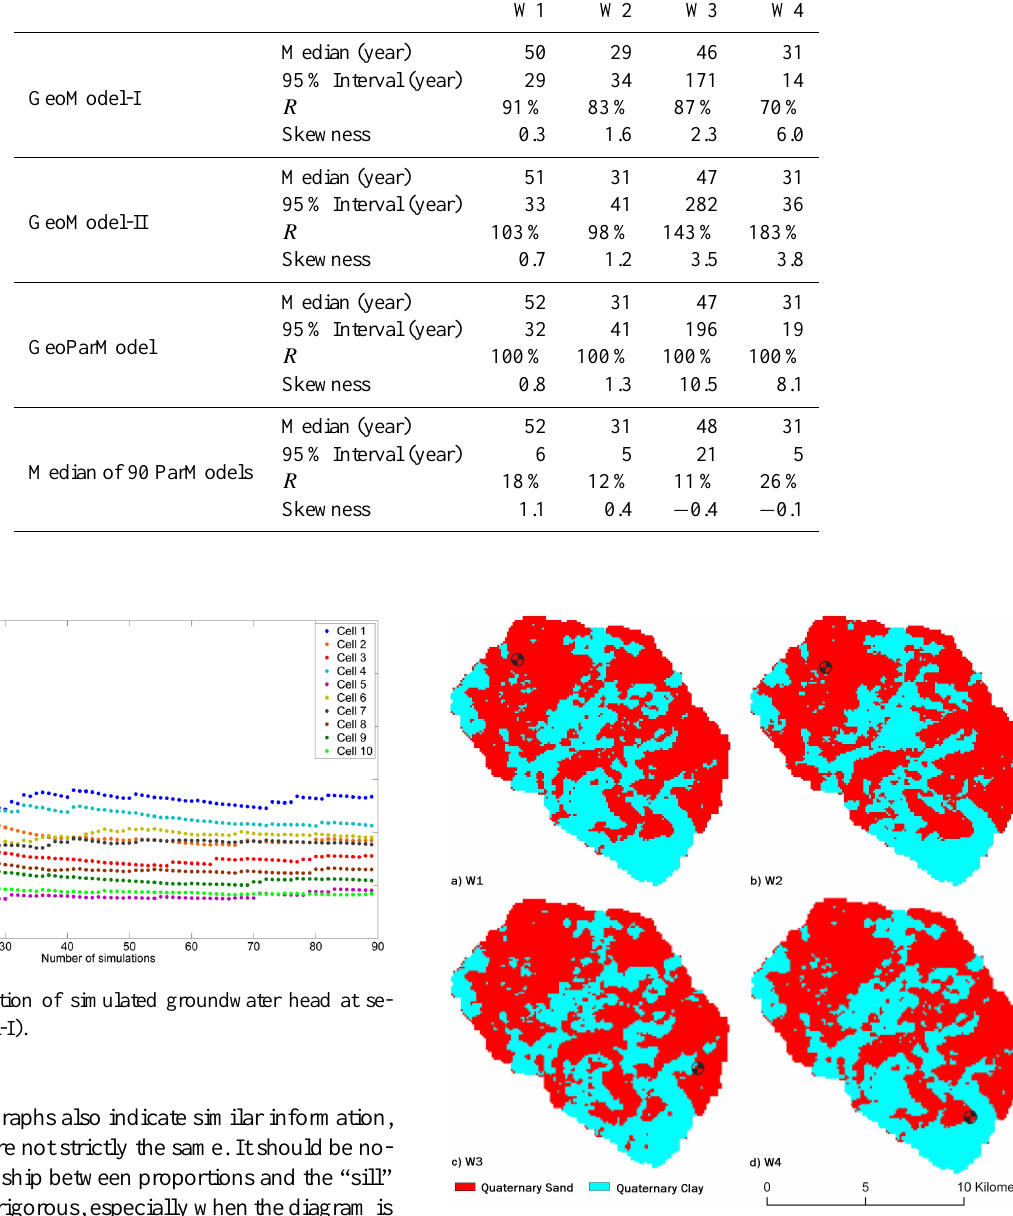
Fig. 8. Location of four wells for backward particle tracking (back- ground shows geological structure of the training image at the depth of the well screen): (a) W1, well screen at 3.66 to − 4.96ma.s.l.; (b) W2, well screen at − 4.98 to − 10ma.s.l.; (c) W3, well screen at 0.44 to − 4.91ma.s.l.; (d) W4, well screen at − 4.93 to −